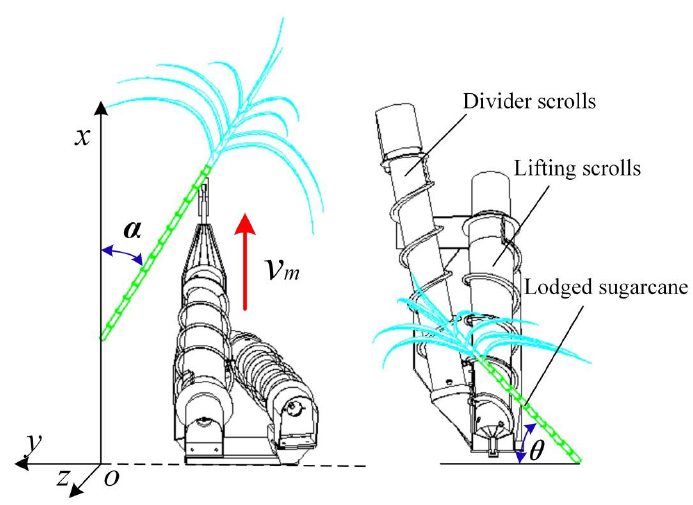
Figure 4. Schematic diagram of sugarcane lodging angle.